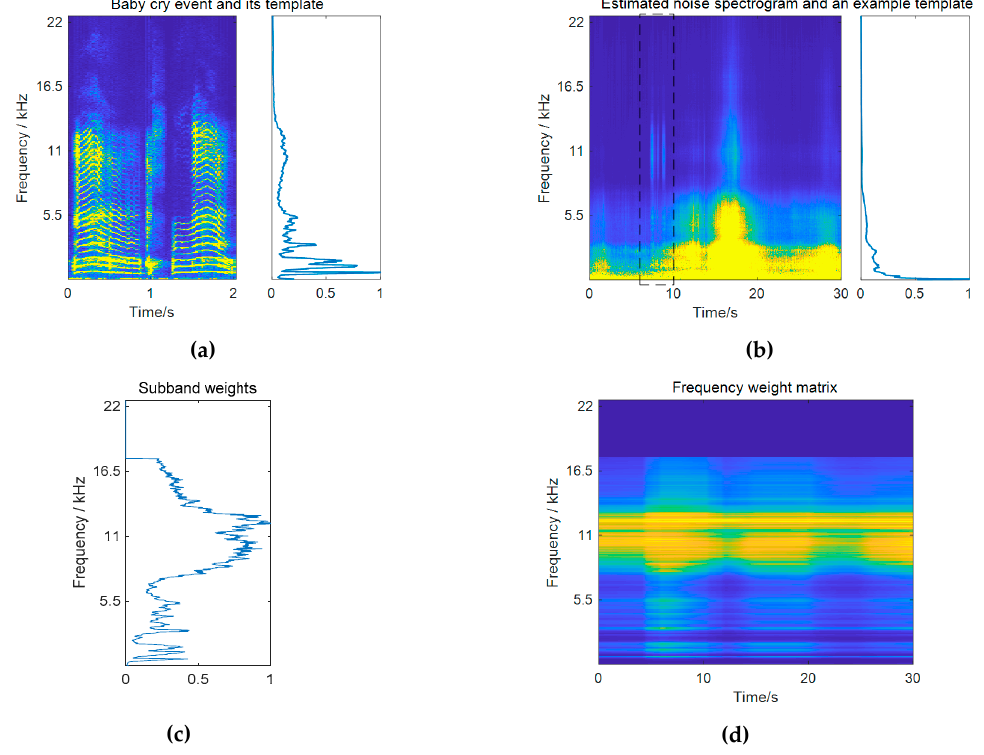
Figure 2. A practical example of calculating subband weights. ( a ) Spectrogram of a baby cry event and its spectral template; ( b ) an example of the estimated noise spectrogram and the noise template for a specific frame (the pictured template is calculated within the frames from 6 s to 10 s, as marked by the dashed box); ( c ) subband weights for that frame; ( d ) subband weight matrix for all frames.